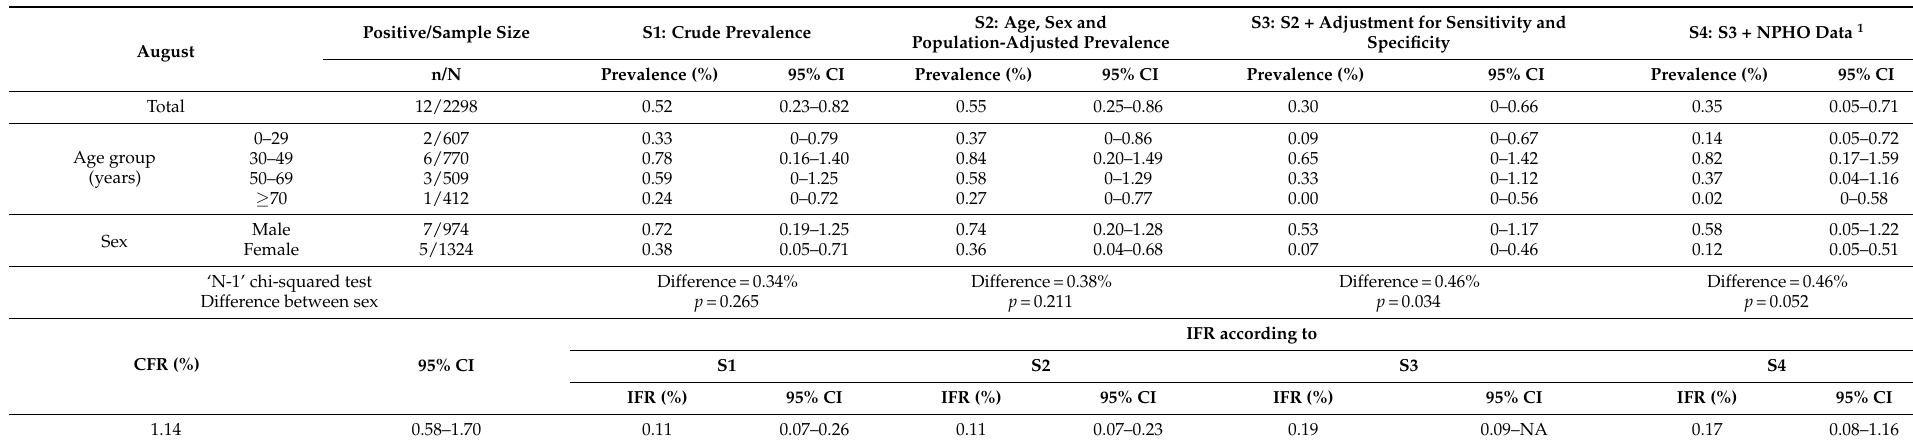
Table 4. Anti-SARS-CoV-2 IgG antibody seroprevalence, Greece, August 2020 ( n =